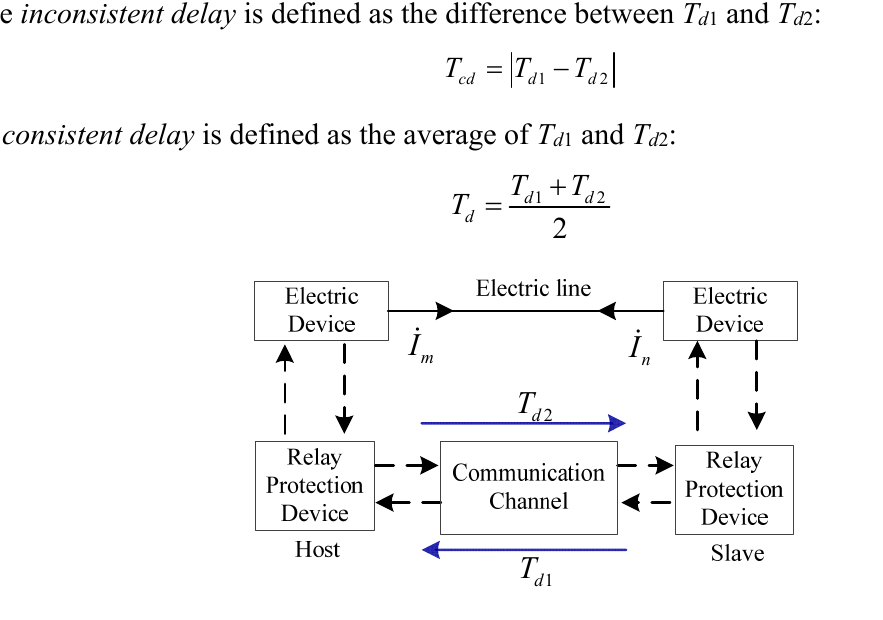
Figure 1. Signal transmission in current differential